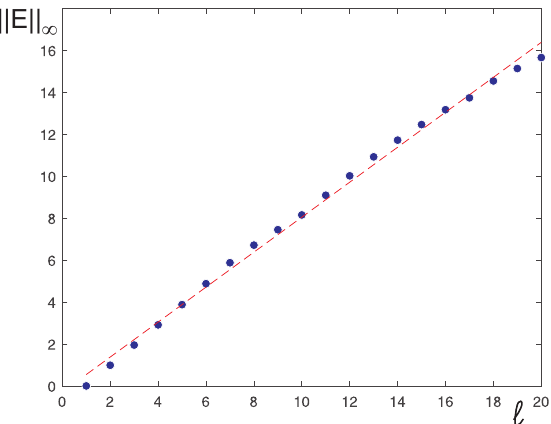
Figure 4. Diagram of || E || ∞ as a function of the number (cid:96) of DG systems.